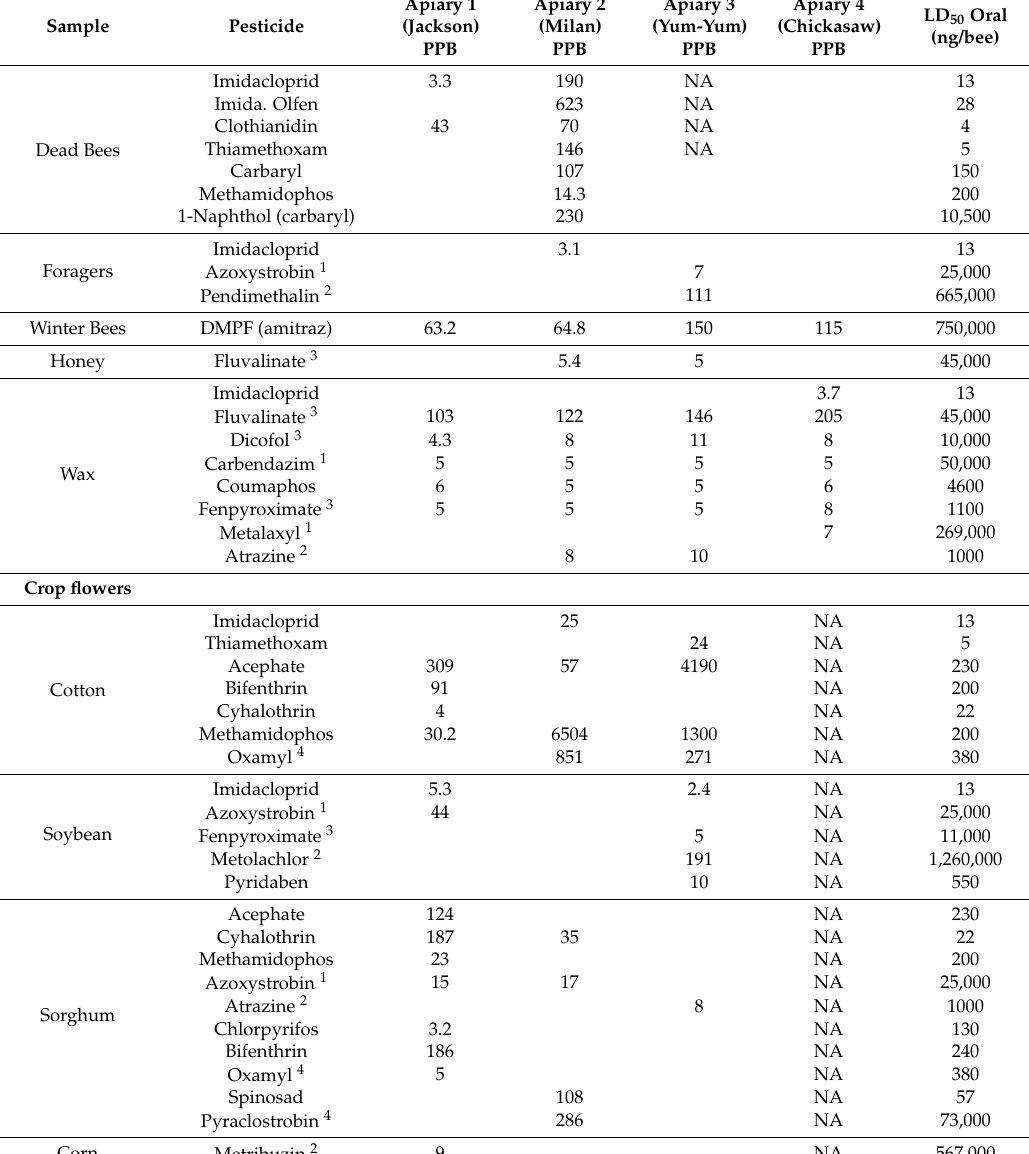
Table 3. Results of the pesticide residue detection performed by liquid chromatography-mass spectrometry (LC-MS) for dead bees, foragers, honey, wax, and crop flowers from each location. LD 50 is based on the data provided by [44] and the Ecotoxicology databases of the US Environmental Protection Agency. Level of detection (LOD) varied between 1–50